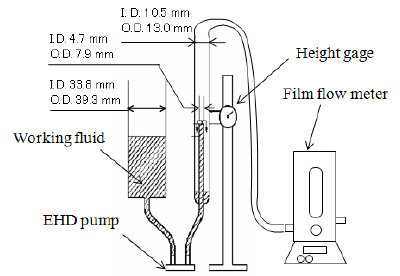
Fig. 8 Apparatus used to measure the mean flow rate